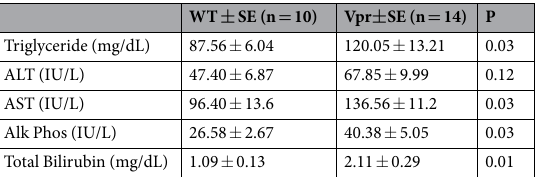
Total Bilirubin (mg/dL) 1.09 ± 0.13 Table 1. Plasma triglycerides and liver functions in Vpr-Tg and WT mice.